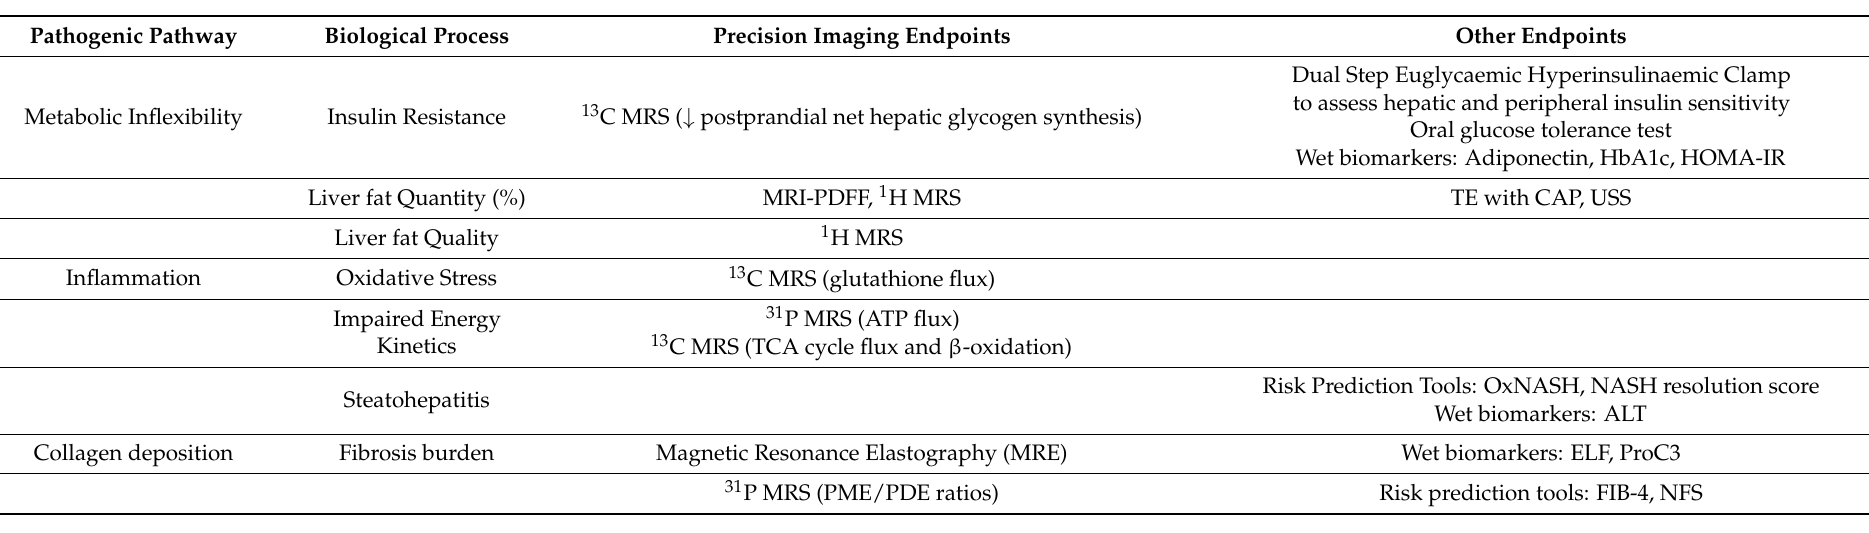
Table 2. Non-invasive quantitative biomarkers with which to probe NAFLD, NASH and fibrosis burden. NFS = NAFLD fibrosis score; FIB-4 = fibrosis-4 index; ELF = extended liver fibrosis panel; ProC3 = pro-collagen C3; ALT= alanine aminotransferase; TE = transient elastography; CAP = controlled attenuation parameter USS = ultrasound; HOMA-IR =